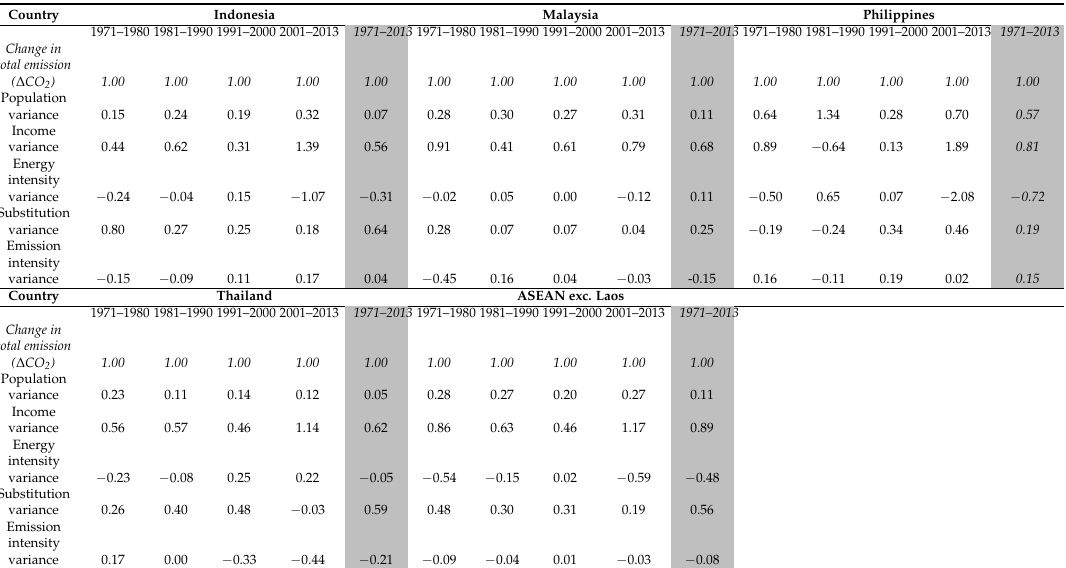
Table A2. Decomposition results of total CO 2 emissions in ASEAN and selected countries (Share).